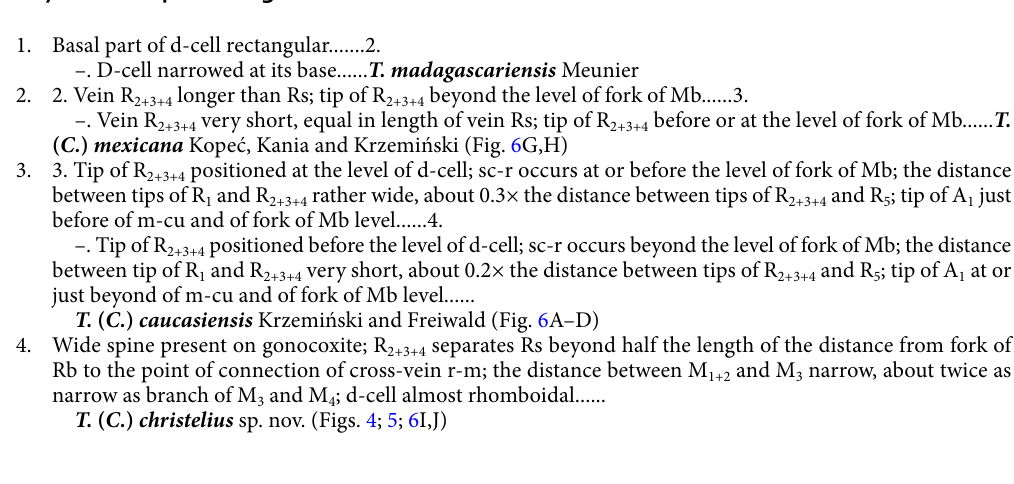
is situated far beyond level of d-cell, while for example in T. ( C. ) caucasiensis vein R 2+3+4 is rather short and its tip is situated approximately at the level of half d-cell. In T. ( C. ) mexicana R 2+3 is very short, equal in length to Rs, while in all known from fossil record species is longer. In T. ( C. ) eridanus and T. ( C. ) christelius sp. nov. sc-r occur before or at fork of Rb, in T. ( C. ) caucasiensis beyond this bifurcation. In addition, the distance between veins M 1+2 and M 3 in the T. ( C. ) christelius sp. nov. is narrow, what is well visible at the level of vein m-m, in T. ( C. ) caucasiensis , T. ( C. ) eridanus or T. ( C. ) mexicana veins M 1+2 and M 3 are widely separated. In contrast to T. ( C. ) madagascariensis , basal part of d-cell of T. ( C. ) madagascariensis is narrowed, in new species is distinctly wide. Key to fossil species of genus Toxorhina .